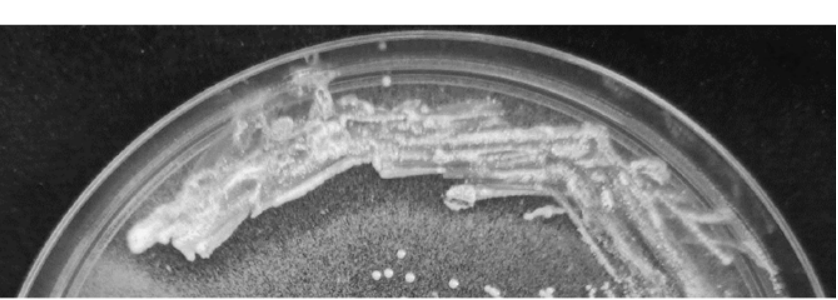
Fig. 2. Uricase activity of L. brevis SF121 presented by clear zone on MRS medium containing uric